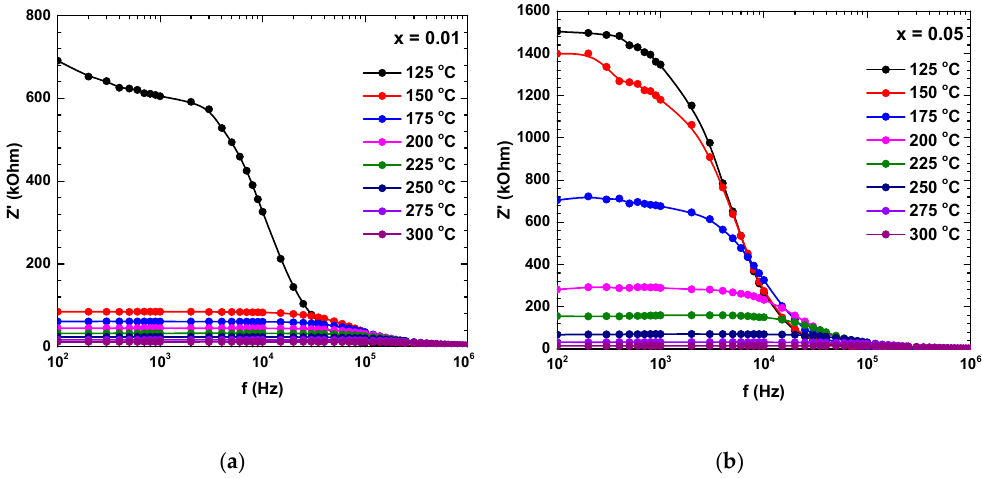
Figure 5. Bode plots for Z’(f) of LaFe 1 − x Zr x O 3 with ( a ) x = 0.01 and ( b ) x = 0.05 annealed at 800 °C for 6 h at different temperatures. 6 h at di ff erent temperatures.